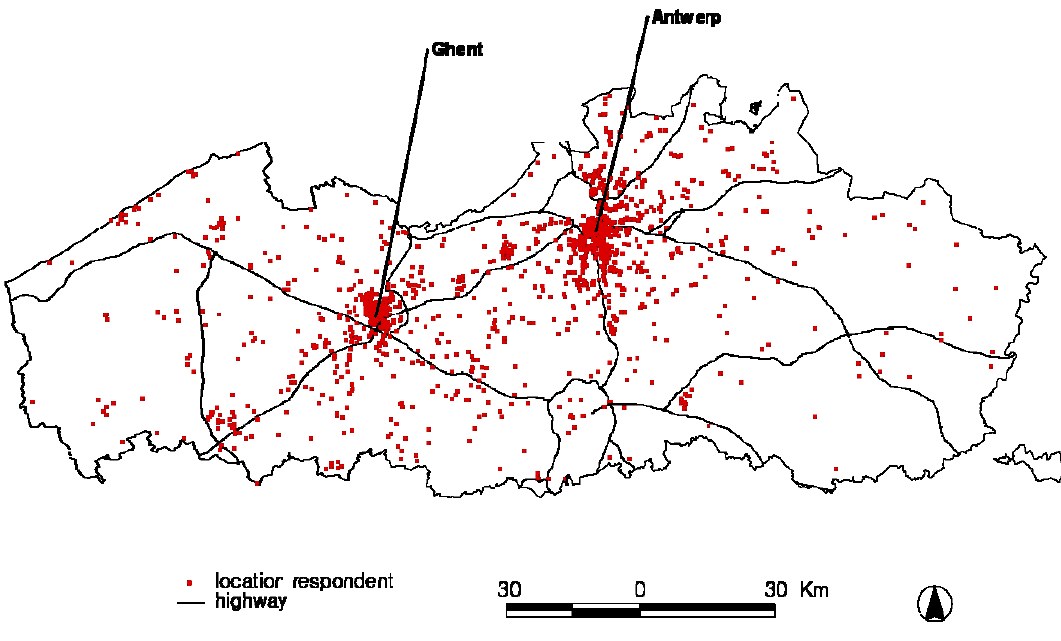
Figure 2. Locations of respondents in Flanders Table 1. Socio-economic and socio-demographic characteristics of the respondents Sample